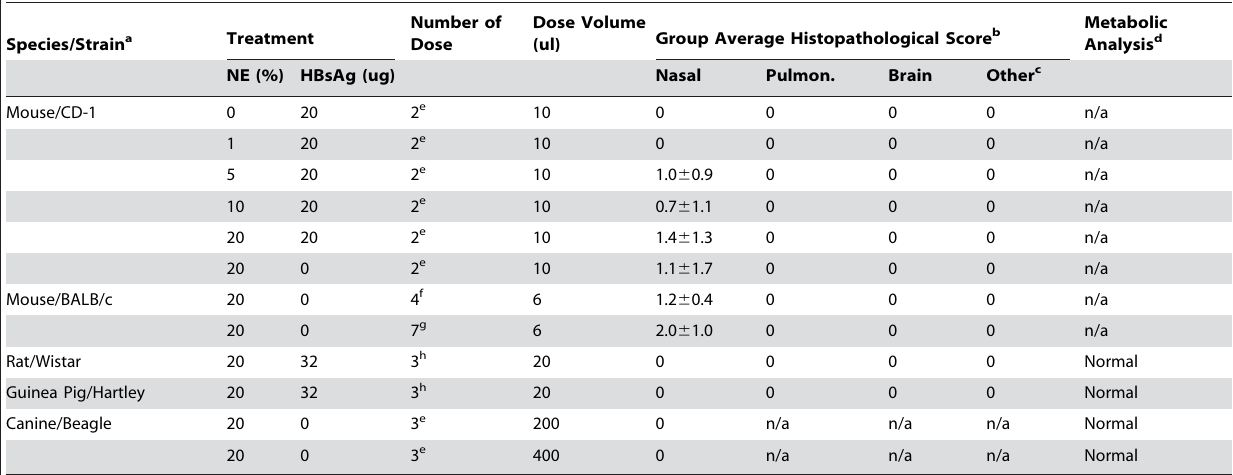
Table 2. Pre-clinical toxicology